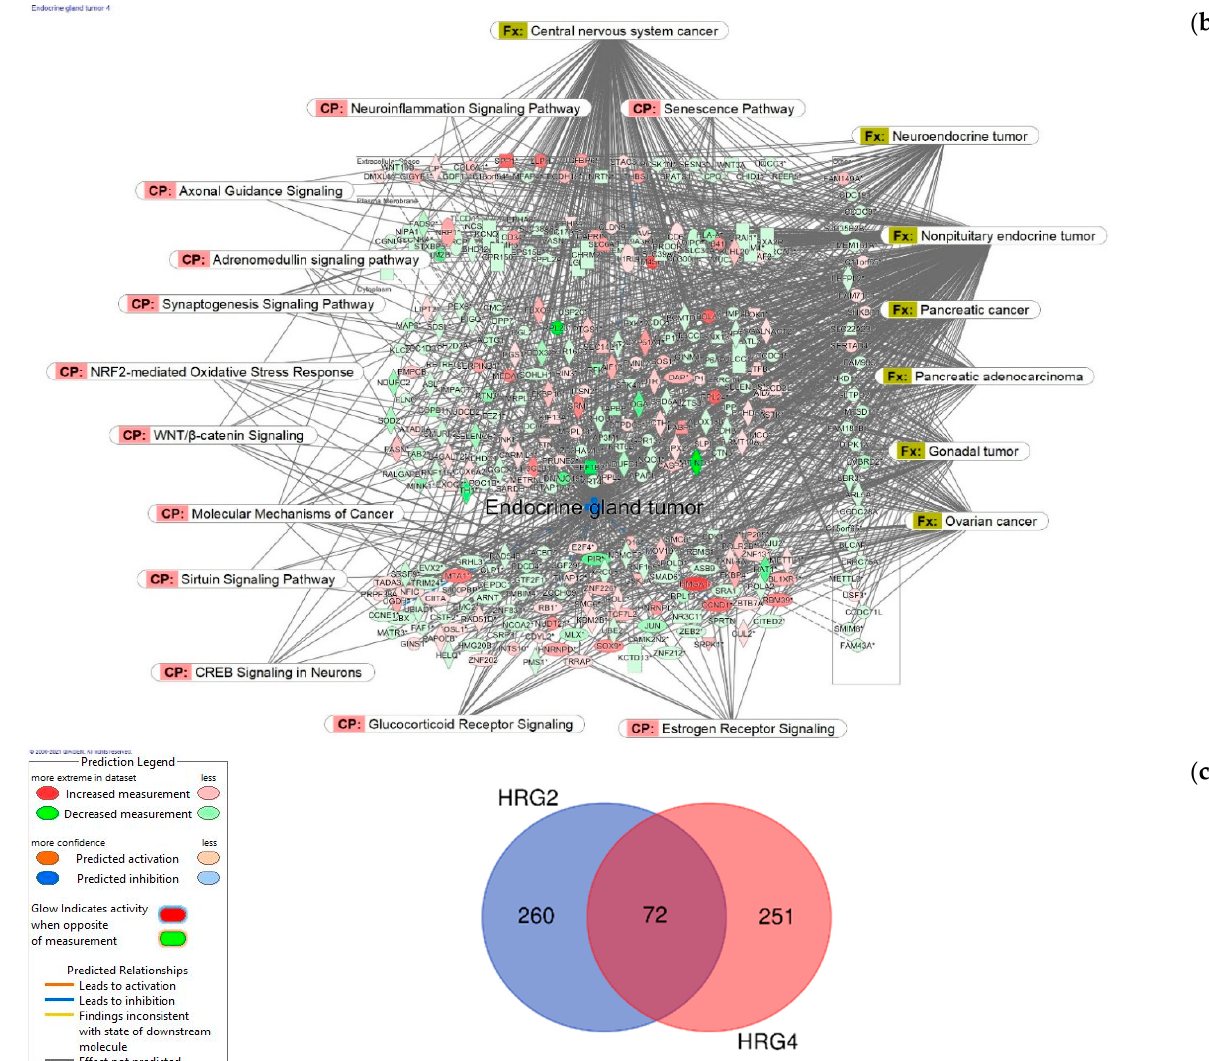
Figure 6. Molecular network shows predicted inhibition of exocrine gland tumor by HRG80 TM at concentrations of: ( a ) 1 μ g/mL and ( b ) 10 pg/mL. Solid red or green color nodes indicate genes that are up-regulated and down-regulated, respectively; color intensity indicates the actual log-fold changes. The tags labeled with purple display the canonical pathways related to particular genes of the network. The tags labeled with khaki show various types of tumors associated with the molecules in subnetworks. ( c ) Venn diagram showing the number of concentration-specific and commonly deregulated (72) genes at concentrations of 1 μ g/mL and 10 pg/mL.